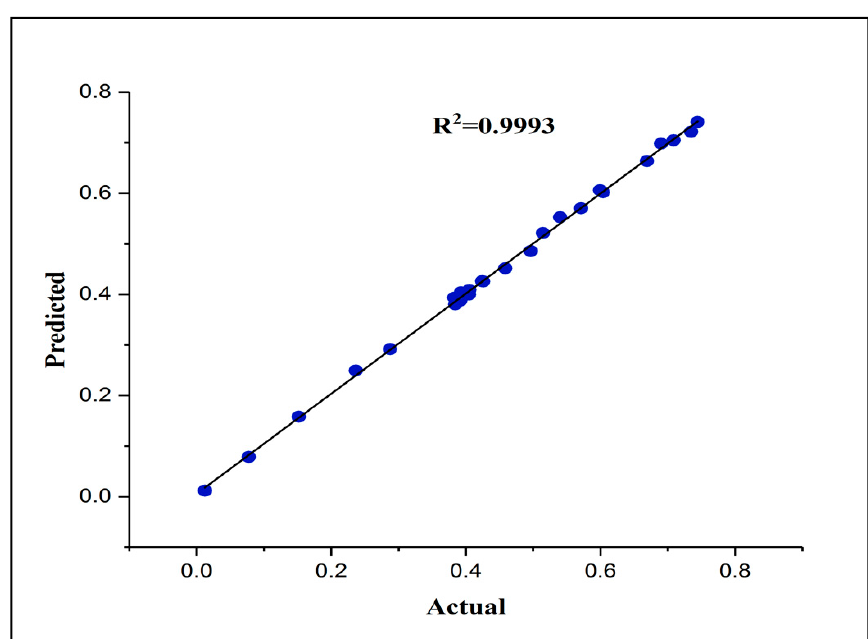
Figure 2. Neural networks’ performance-based MSE ( the mean square error) utilizing different architectures: One and two hidden layers.